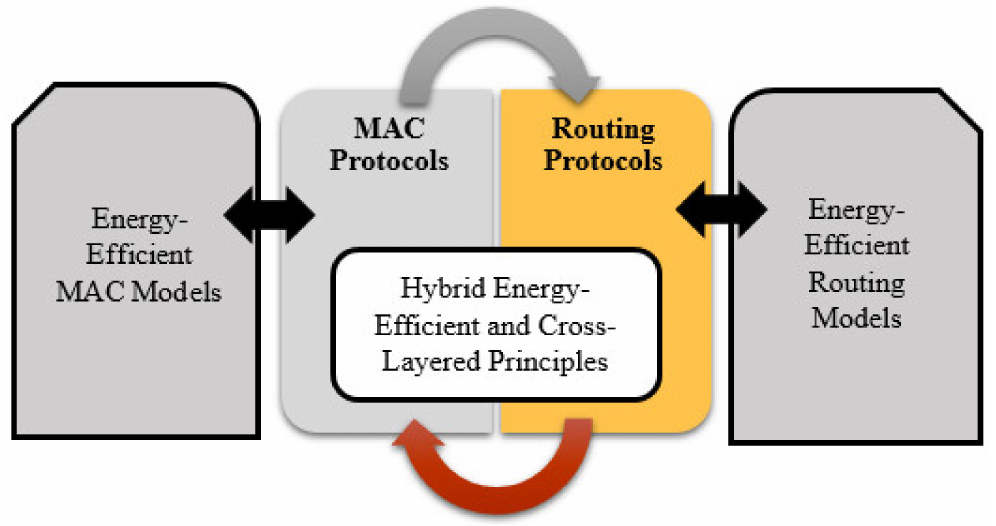
Figure 2. Cross-layered